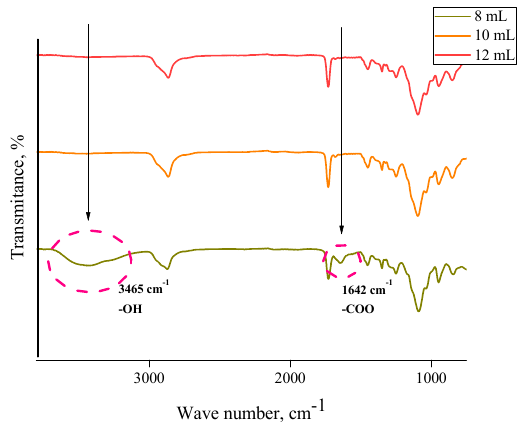
Figure 6. FTIR spectra of materials with different contents of crosslinking agent PEGDA 700 and 10 mL of Aloe vera juice.